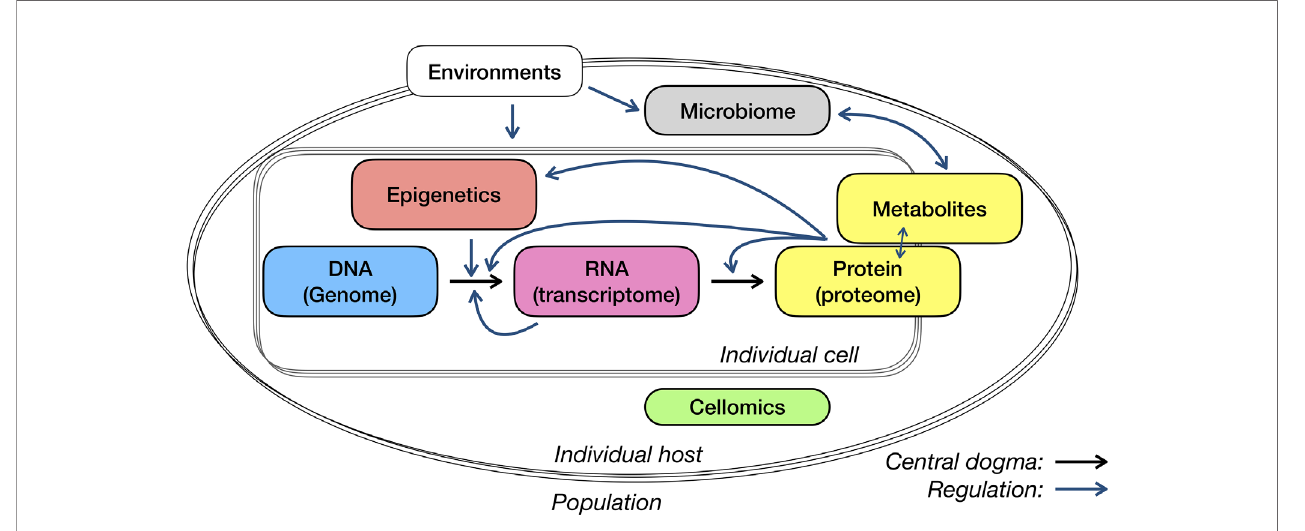
FIGURE 2 | Central dogma and regulations of different omics